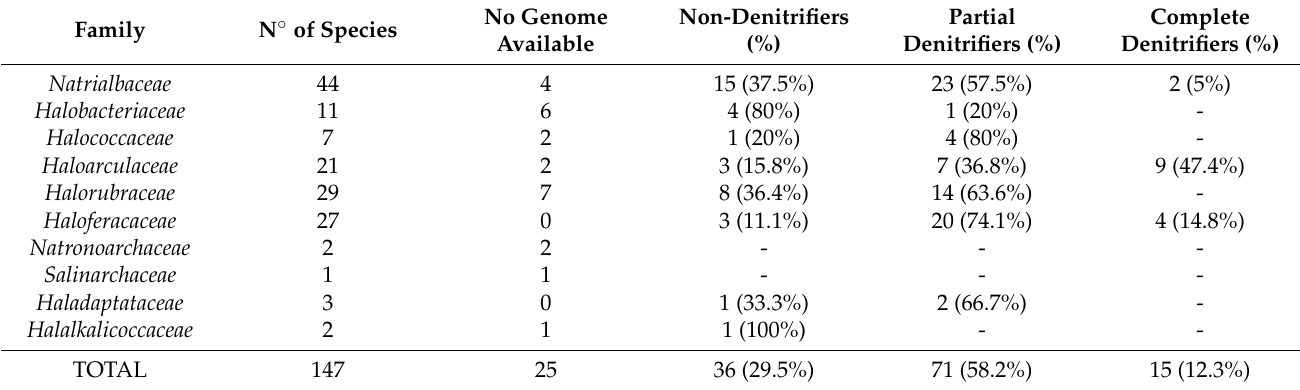
Figure 1. ( a ) Phylogenetic tree built with the 147 species of haloarchaea. Colour ranges indicate the family to which the microorganisms belong, and symbols specify which enzymes possess. NGA: no genome available. Sulfolobus acidocaldarius has been included as the root of the cladogram. ( b ) Distribution of denitrification enzymes among haloarchaea species indicating the number of species that present any of the four main enzymes of denitrification. ND: non-denitrifiers. Table 3. Detailed data by family. Percentages are exclusively calculated with species that present available genome in NCBI